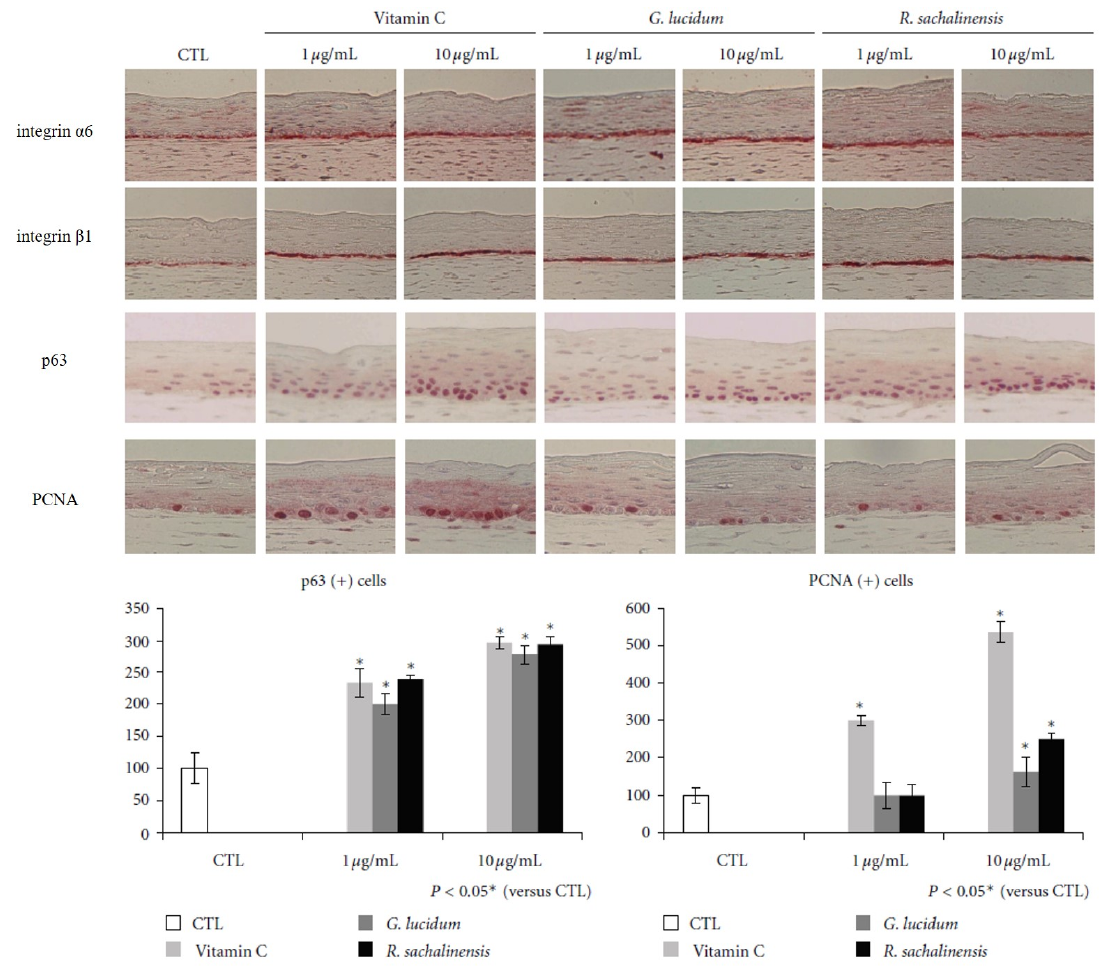
Figure 1. Immunihistochemical staining for integrins, p63, and PCNA. The skin equivalents were constructed and incubated in the presence of vitamin C, G. lucidum , or R. sachalinensis at 1 or 10 µ g / mL. Sections of skin equivalents were stained for integrin α 6, integrin β 1, p63, and PCNA. Staining intensities of both integrins, p63, and PCNA were significantly increased by addition of vitamin C or plant extracts (magnification x200). (* p < 0.05) (modified from the work by Choi et al. [7] )